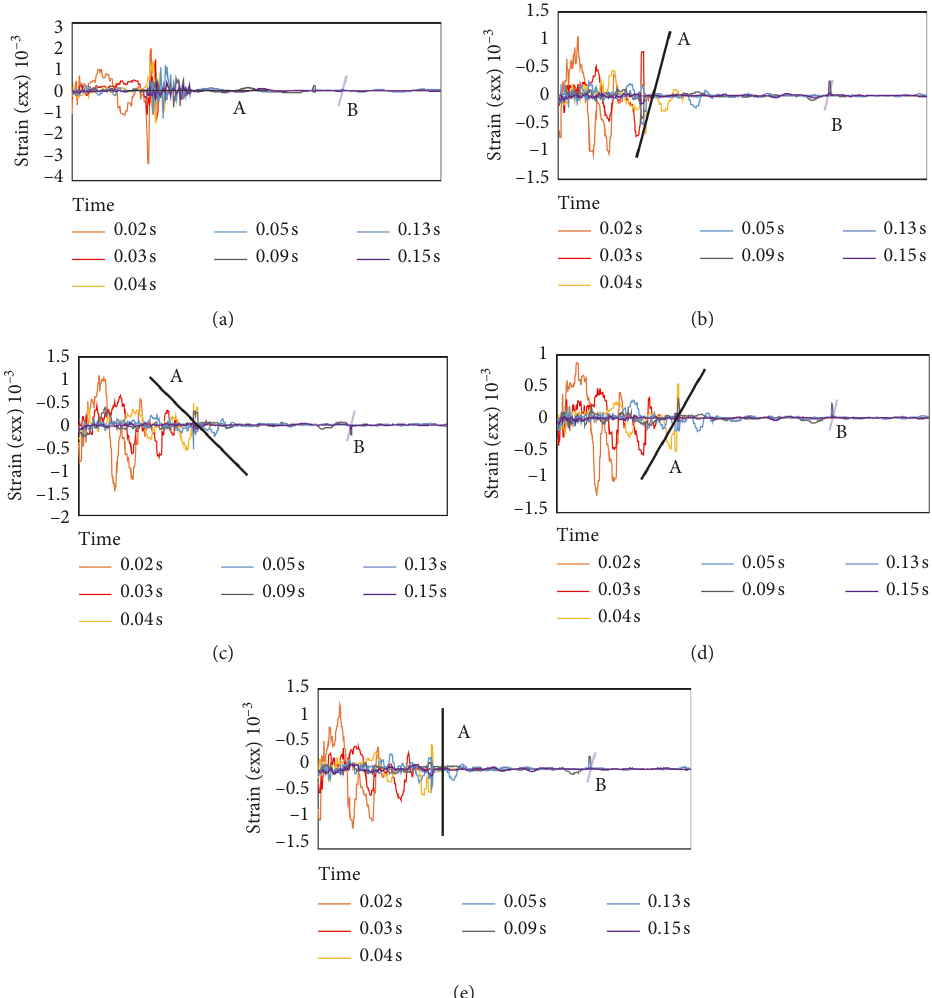
Figure 6: The distribution of strain in the XX direction (Figure 1) at different time influenced by the dip angle of fault A. The vertical axis represents XX strain. The horizontal axis is the middle line (the green dotted line in Figure 1) of the cross section (plane c , boundaries are indicated by the orange dotted lines) in the middle of the model box (as shown in Figures 2–4), representing the distance from the blast loading area to the current position. (a) Case D0. (b) Case D75. (c) Case D135. (d) Case D60. (e) Case